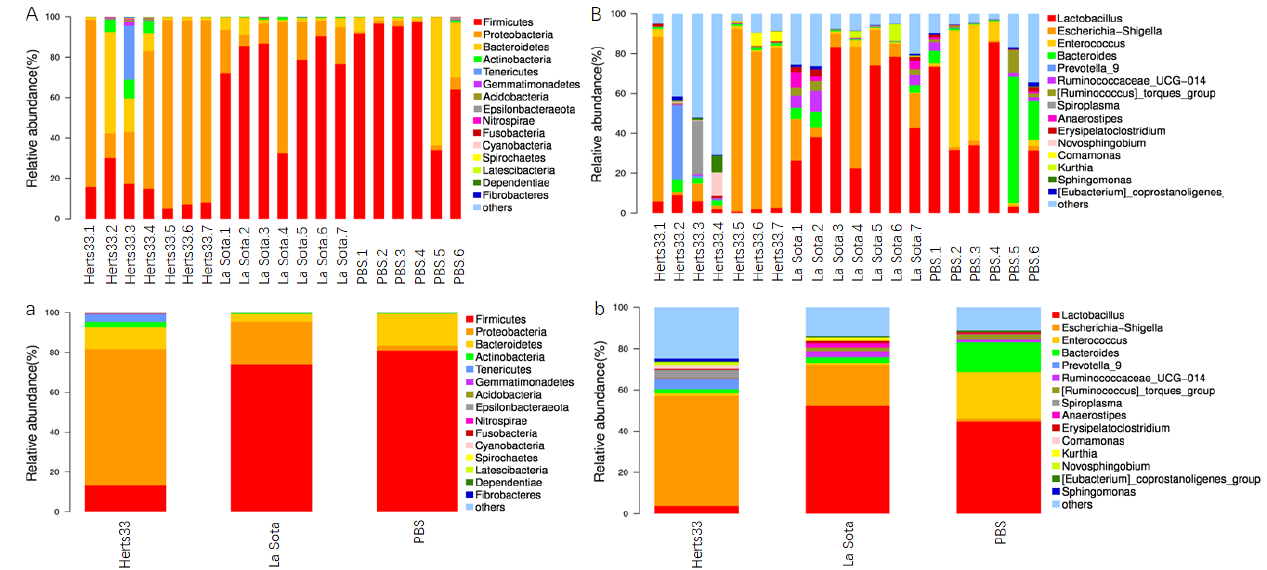
Figure 4. Microbial composition of different samples and groups. Each bar represents the relative abundance of each bacterial taxon within samples or groups. ( A ) Taxa assignments of each sample at Phylum level. ( a ) Taxa assignments of each group at Phylum level. ( B ) Taxa assignments of each sample at Genus level. ( b ) Taxa assignments of each group at Genus level.